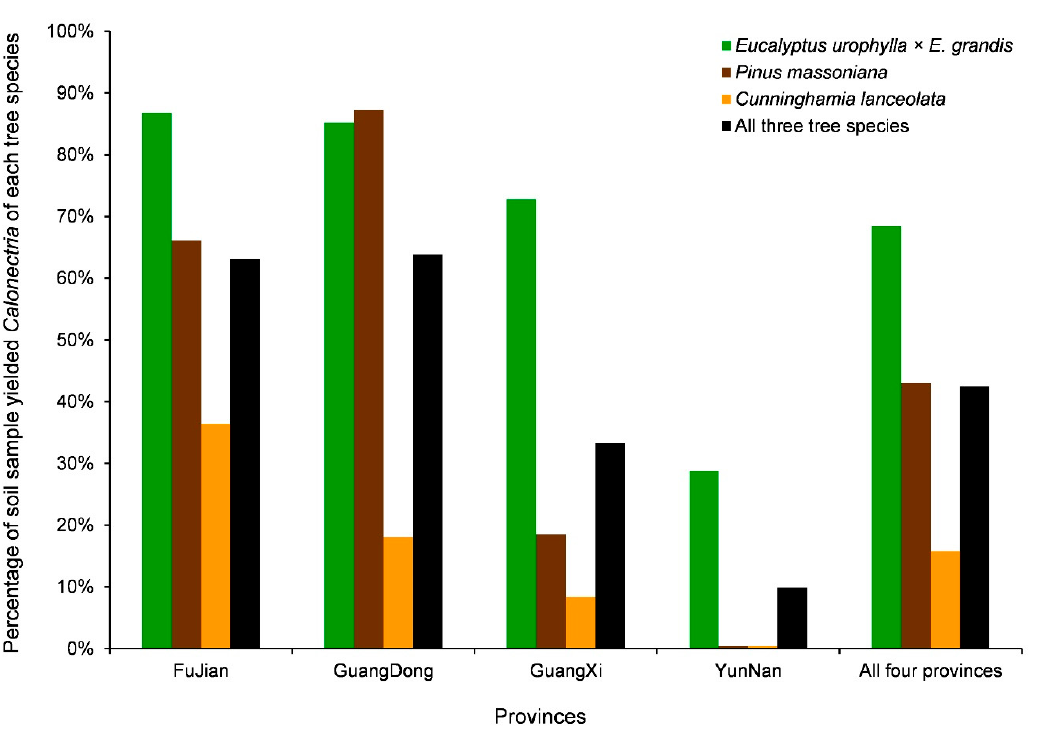
Figure 4. Percentage of soil samples that yielded Calonectria in plantations of three tree species in four regions (provinces).